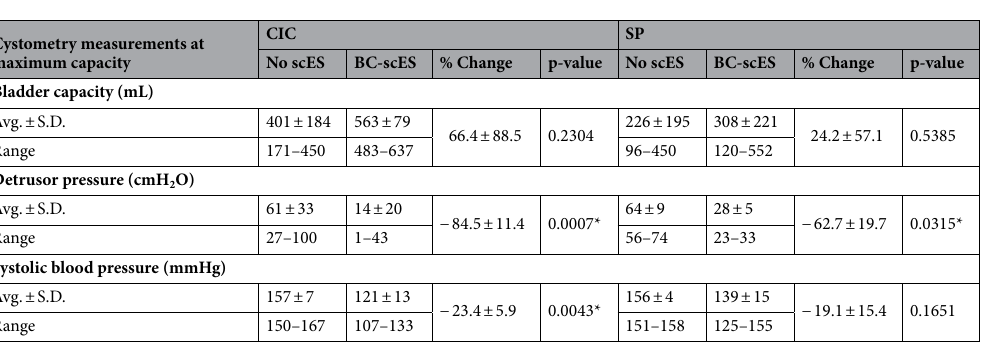
Table 2. Comparison of bladder mapping group outcomes without scES and with targeted BC-scES. *Indicates significance. Avg. average, BC bladder compliance, CIC clean intermittent catheterization, cmH 2 O centimeters of water, mL milliliters, mmHg millimeters of mercury, scES spinal cord epidural stimulation, S.D. standard deviation, SP suprapubic catheter.